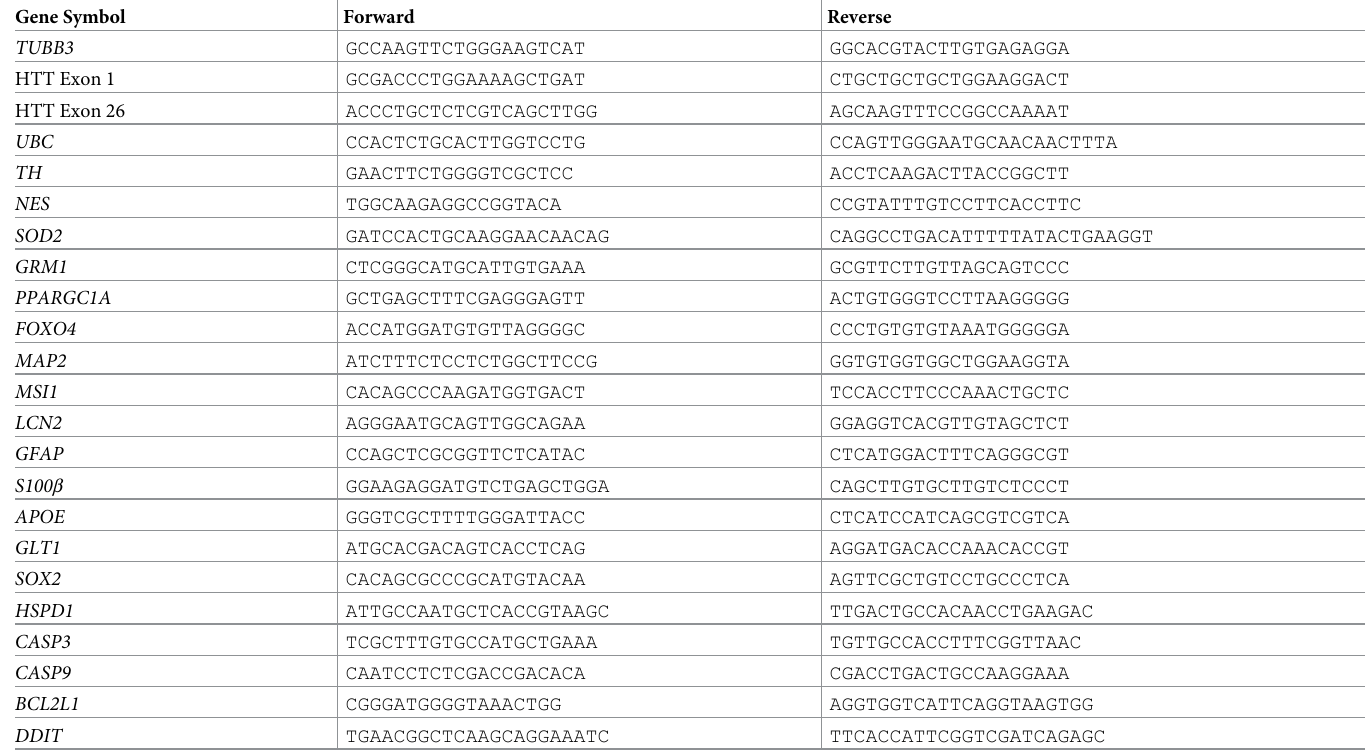
Table 1. SYBR Green primer sequences.